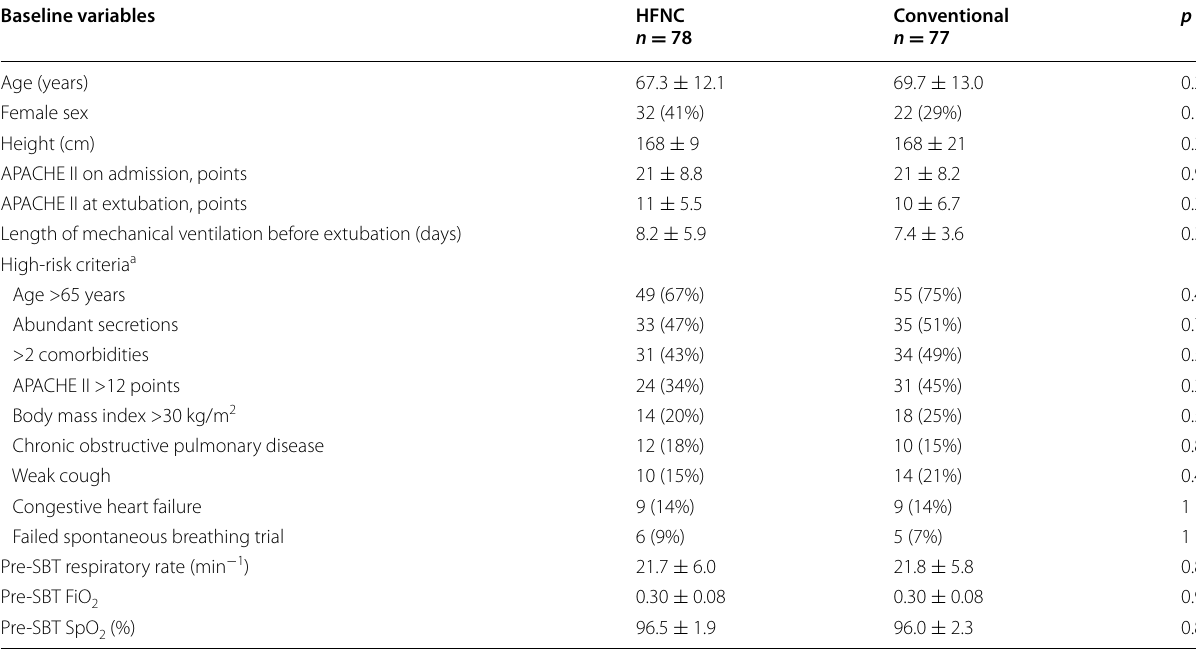
Table 1 Characteristics at randomization of patients in the HFNC group versus those in the conventional oxygen therapy group